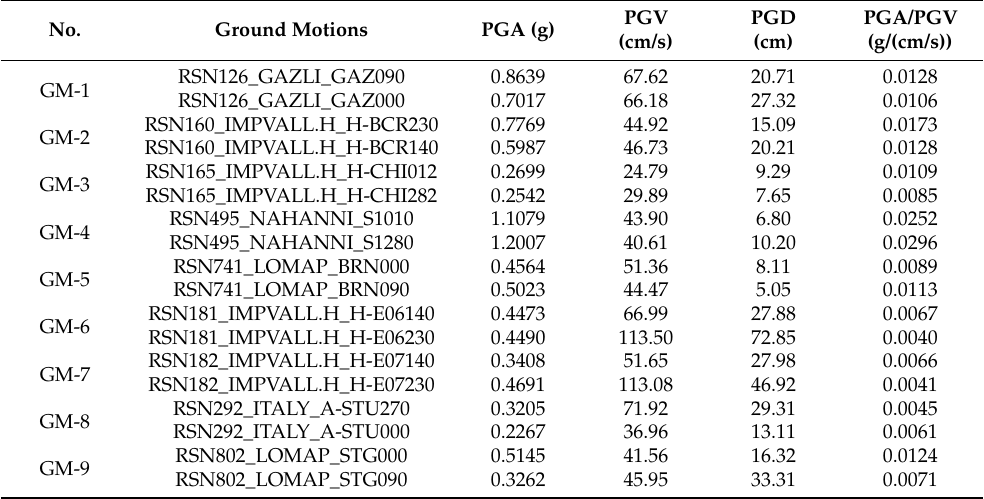
Table 3. Ground motion